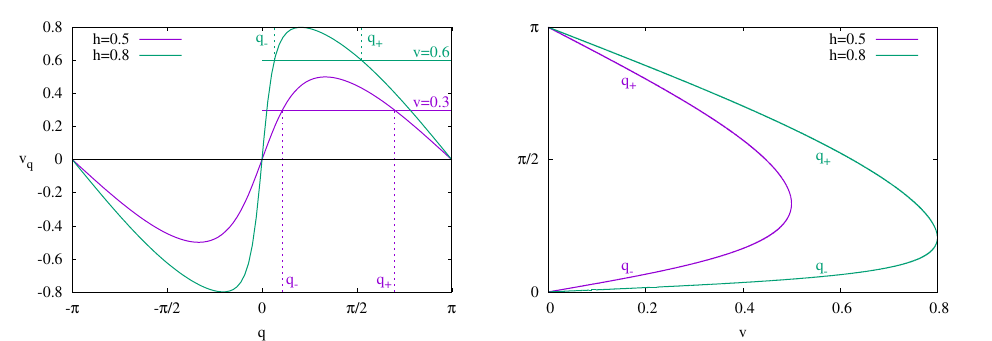
= v . Right: wave numbers q q